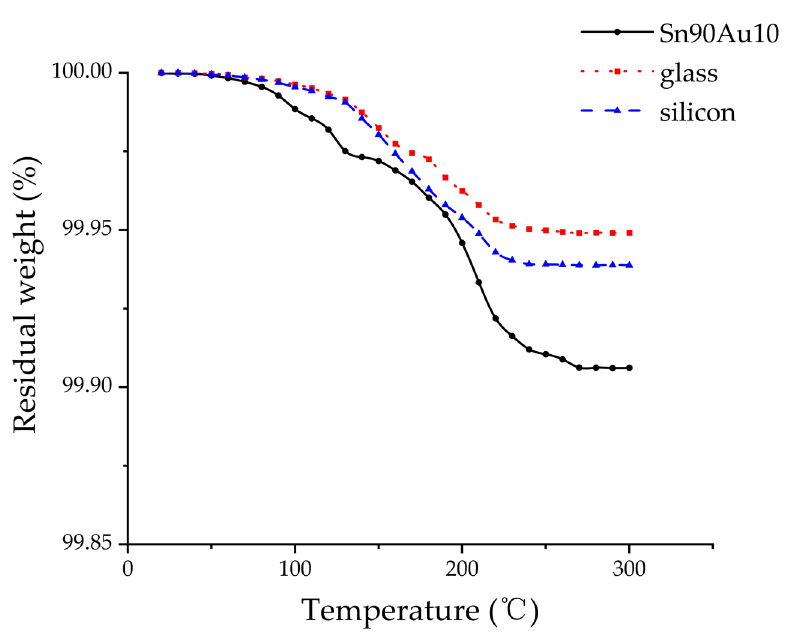
Figure 7. Typical TGA results of Sn90Au10 solder, glass and silicon.